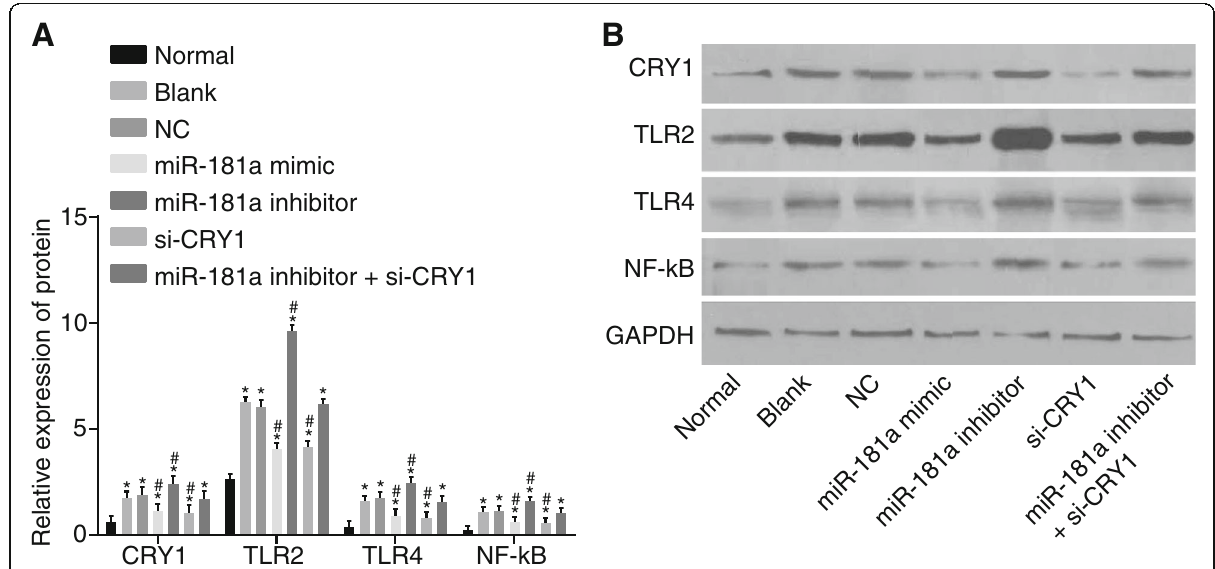
Fig. 10 Western blot reveals that up-regulated miR-181a or down-regulated CRY1 inhibits the activation of the TLR/NF- κ B pathway by decreasing the protein expression of TLR/NF- κ B pathway-related genes. Notes: Panel a , bar graph of protein expression of CRY1, TLR2, TLR4, and NF- κ B in each group; Panel b , protein bands of CRY1, TLR2, TLR4, and NF- κ B in each group; * , p < 0.05 vs. the normal group; # , p < 0.05 vs. the blank and NC groups; the data are presented as the mean ± standard deviation, analyzed by one-way ANOVA; the experiment was independently repeated three times; NC, negative control; miR-181a, microRNA-181a; CRY1, cryptochrome 1; TLR2, toll-like receptor 2; TLR4, toll-like receptor 4; NF- κ B, nuclear factor-kappa B; CKD, chronic kidney